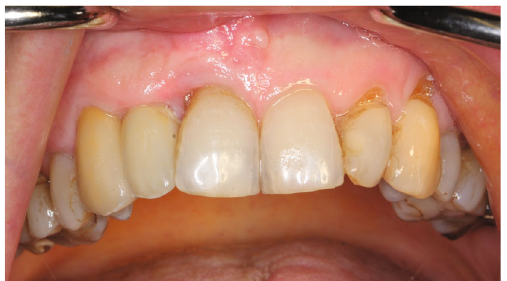
Figure 18: Implant prosthetic result after augmentation with 3D BB, implantation of a BLT implant with CARES abutment, and ceramic crown (anterior view).